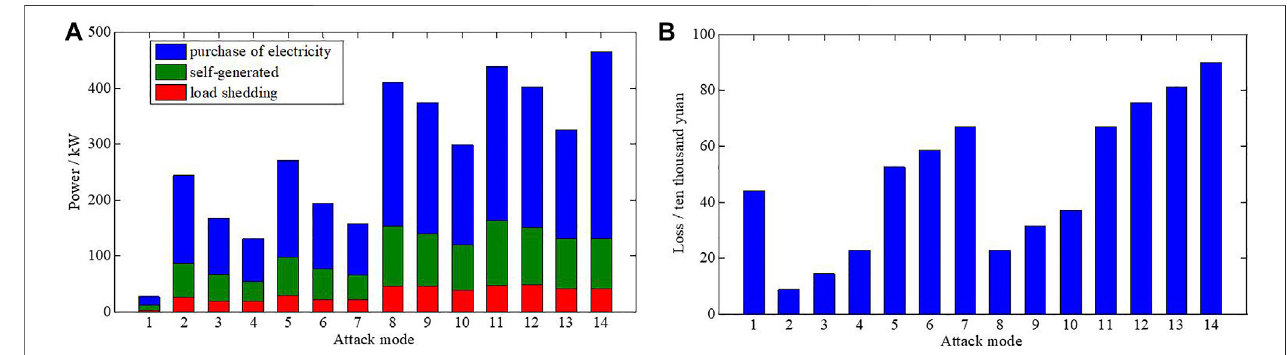
FIGURE 8 | (A) Purchase of electricity, self-generated power, and load shedding under different attack modes. (B) Quanti fi cation of attack consequences.